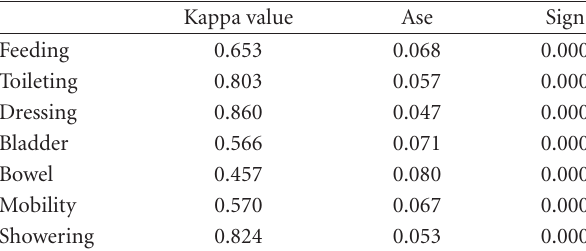
Table 2: Agreement between the FIM and the NPDS for di ff erent basic ADL areas.